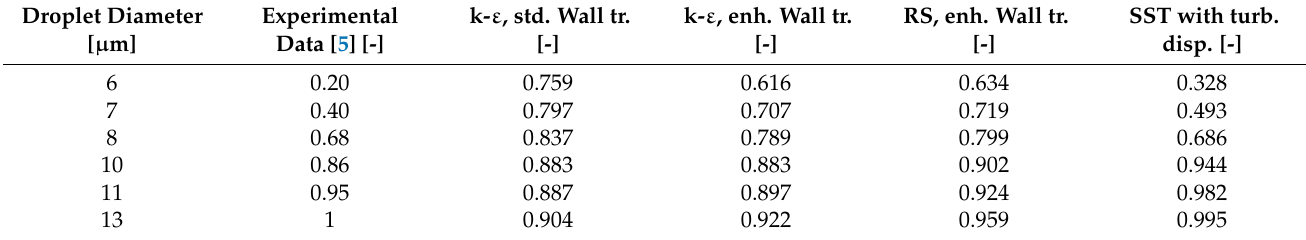
Table 4. Comparison of calculated results with experimental data for geometry B_10_0 with inlet velocity 4 m s − 1 . Droplet Diameter